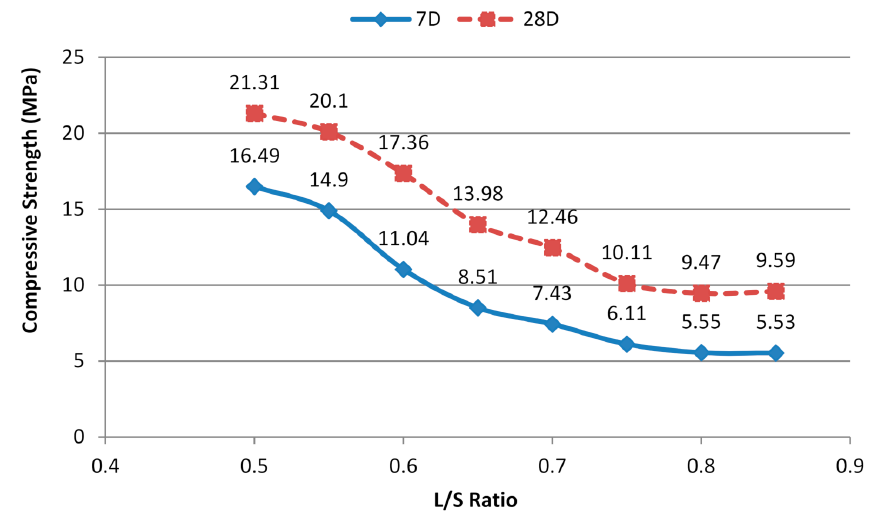
Figure 6. Compressive strength of alkali-activated POFA paste at different L/S